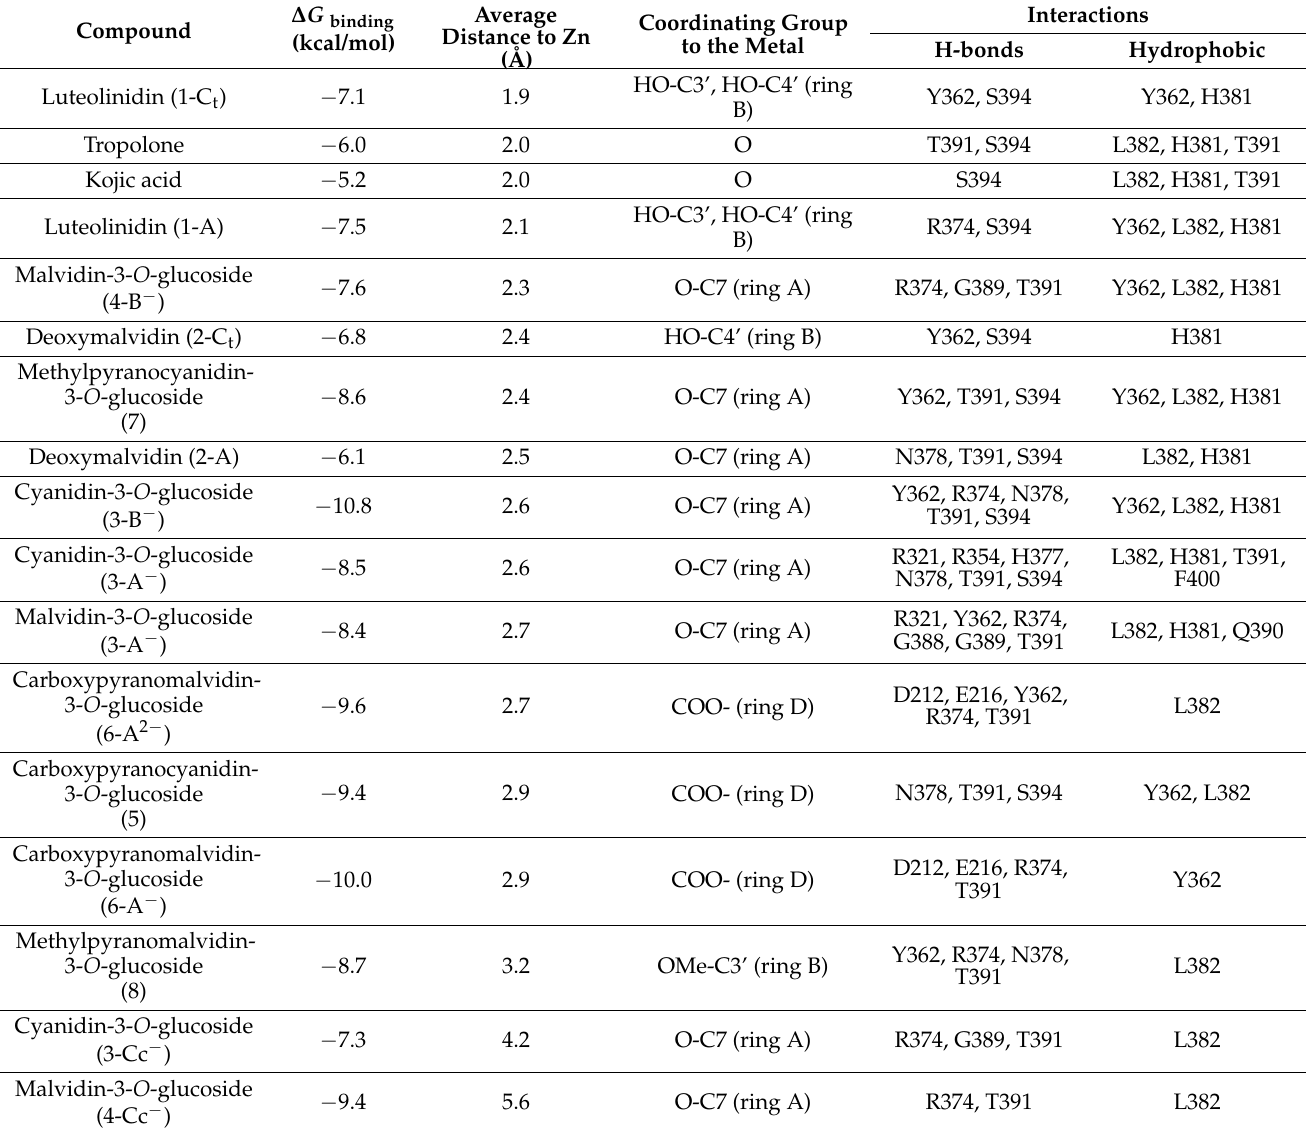
Table 4. Affinity energy values for the best poses of all compounds into the active site of hTYRP1, the average distance for the closest Zn-coordinating group, and the most relevant interactions between tyrosinase and all the potential inhibitors. Compounds ranked by their distance to the metal